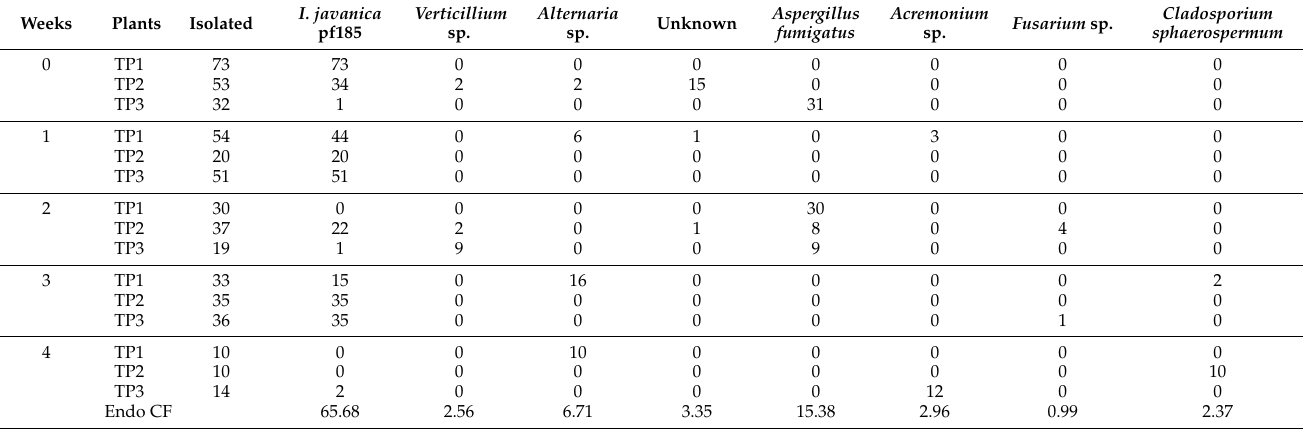
Table 6. Endophytic fungi isolated weekly from leaf tissues.